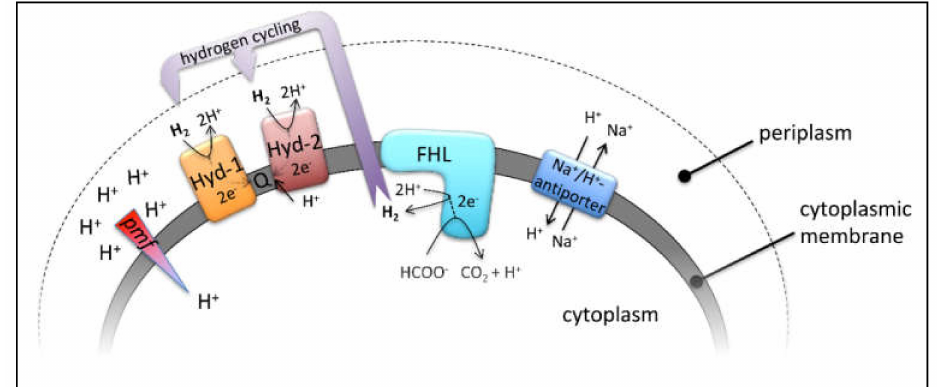
Figure 1. Relevant enzyme complexes of this study, their reactions and their membrane localization. Hyd-1 and Hyd-2 indicate the periplasmic H 2 -oxidizing hydrogenases, which channel electrons into the quinone pool (Q), FHL—the cytoplasmic formate hydrogenlyase—and the membrane bound Na + / H + antiporters. Further details are highlighted in the main